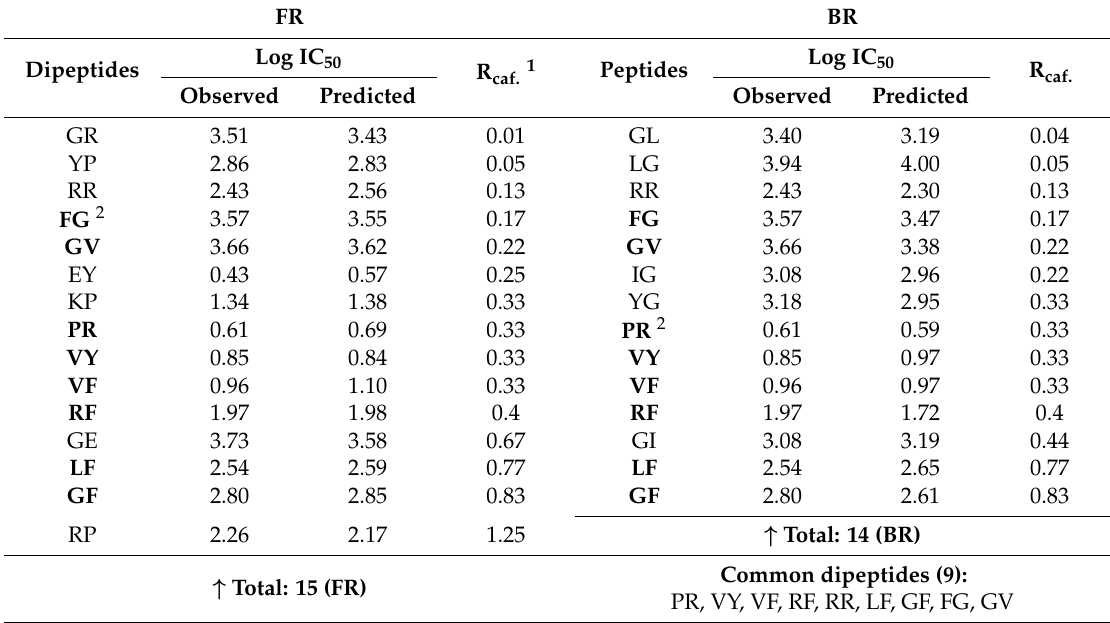
Log IC 50 R caf.